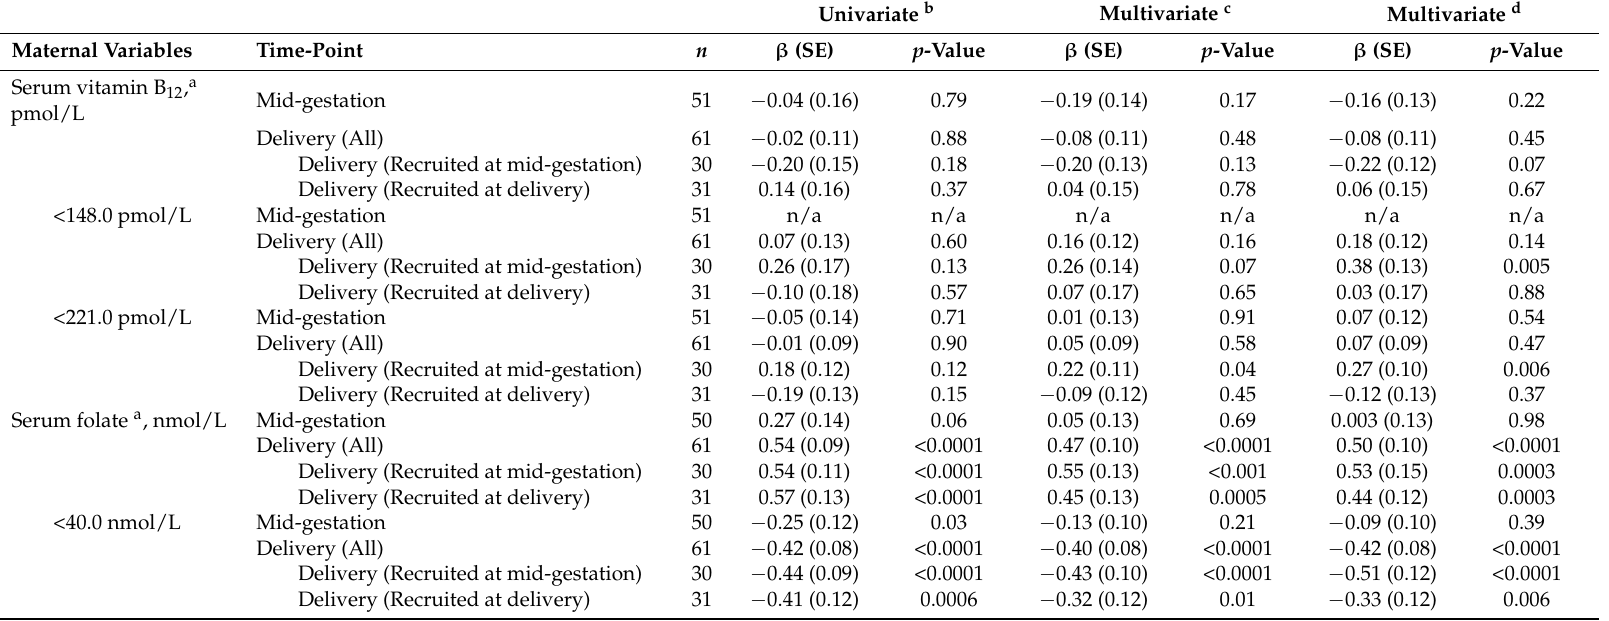
Table 4. Associations between maternal Vitamin B 12 and folate status with infant serum folate concentrations. Univariate b Multivariate